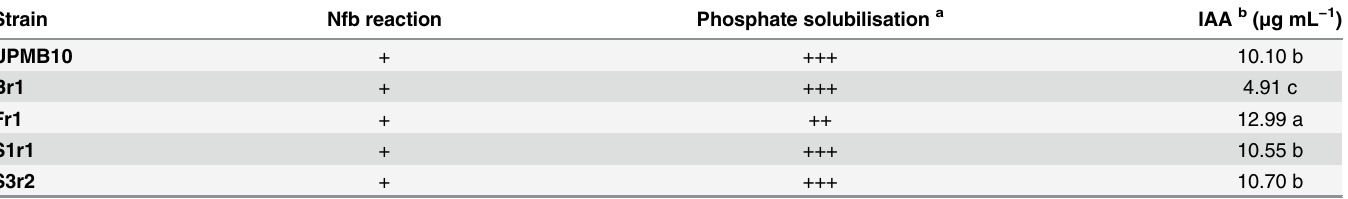
Table 1. Plant growth promoting (PGP) abilities of the five strains used in the glasshouse experiment.